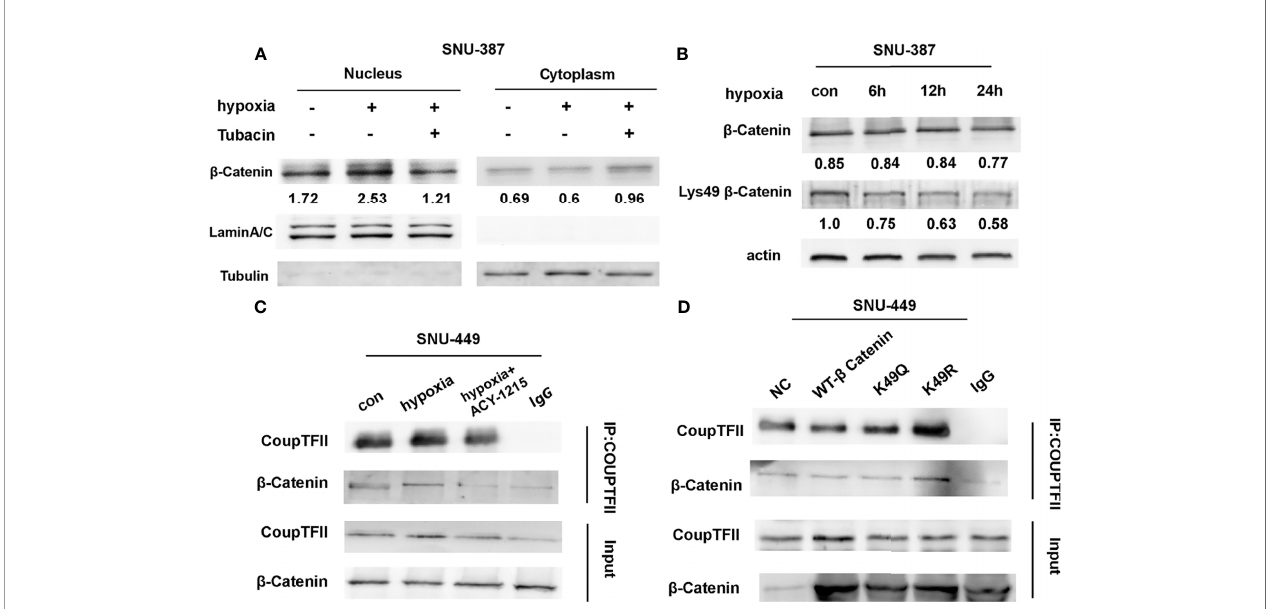
FIGURE 4 | Acetylation affected the interaction between b -Catenin and COUP-TFII. (A) Western blotting was used to analysis the expression of b -Catenin in SNU- 387 cells treated with Tubacin under hypoxia. (B) SNU-387 cells were exposed to hypoxic conditions and treated with Tubacin for 6h. Then total cell lysates were subjected to western blot analysis. (C) SNU-449 cells were exposed to hypoxic conditions and treated with ACY-1215 for 6h. Immunoprecipitation was performed using anti-COUP-TFII and precipitated proteins were identi fi ed by immunoblotting. (D) SNU-449 cells were transfected with wt- b -Catenin and b -Catenin acetylation- mimetic mutants and immunoprecipitation was performed as C